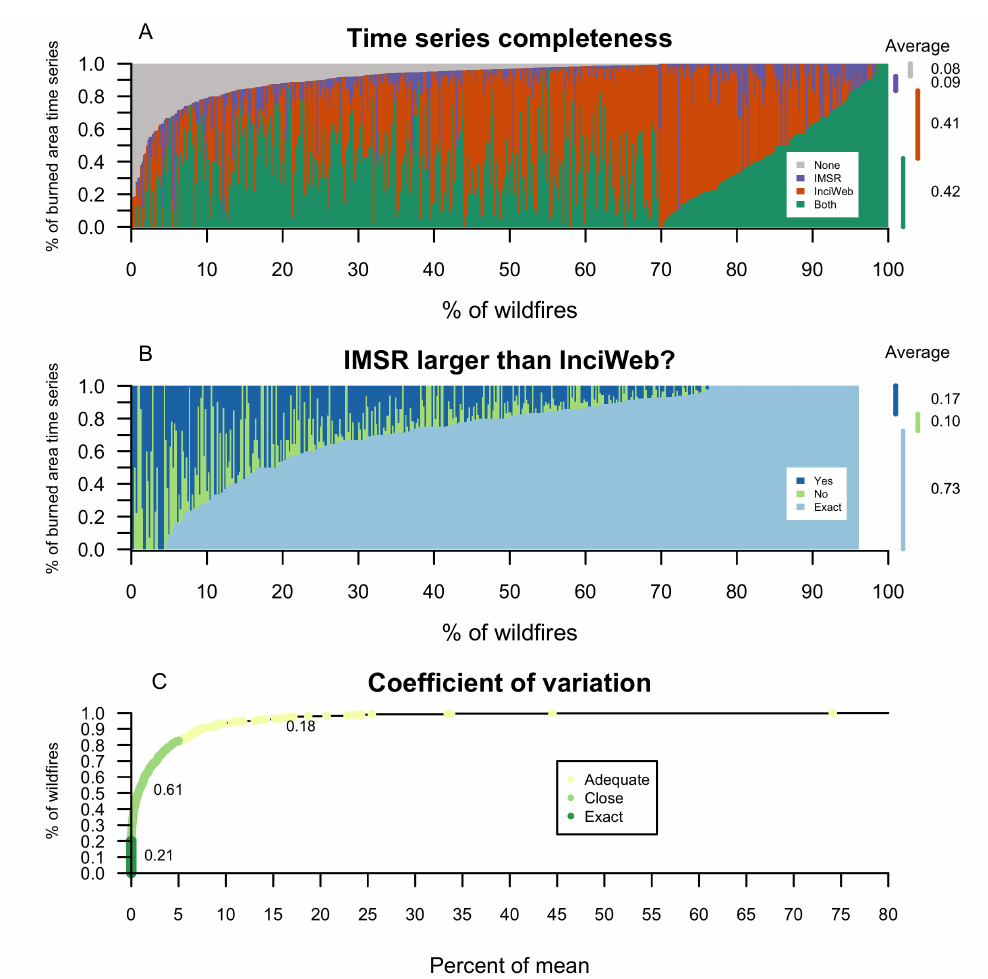
Figure 6. Graphical summaries of burned area time series (BATS) data availability and coherence in the WoMBATS data. Panel ( A ) describes the data completeness. Each vertical bar represents the proportion of each BATS where one, both, or none of the data sources are available. Panel ( B ) characterizes the level of agreement between InciWeb and IMSRs when both are available in terms of biases. Each vertical bar represents the proportion of the BATS measurements with cross-check data where IMSR measurements are larger, InciWeb measurements are larger, or are the same. BATS with no cross-check data are represented with white space. In Panels ( A , B ), wildfires are ordered by BATS completeness and the level of agreement, respectively. Panel ( C ) shows the empirical cumulative distribution of the coefficient of variation calculated from the 494 fires with cross-check data. Colored points are used to represent which data quality category [42] applies to each wildfire’s